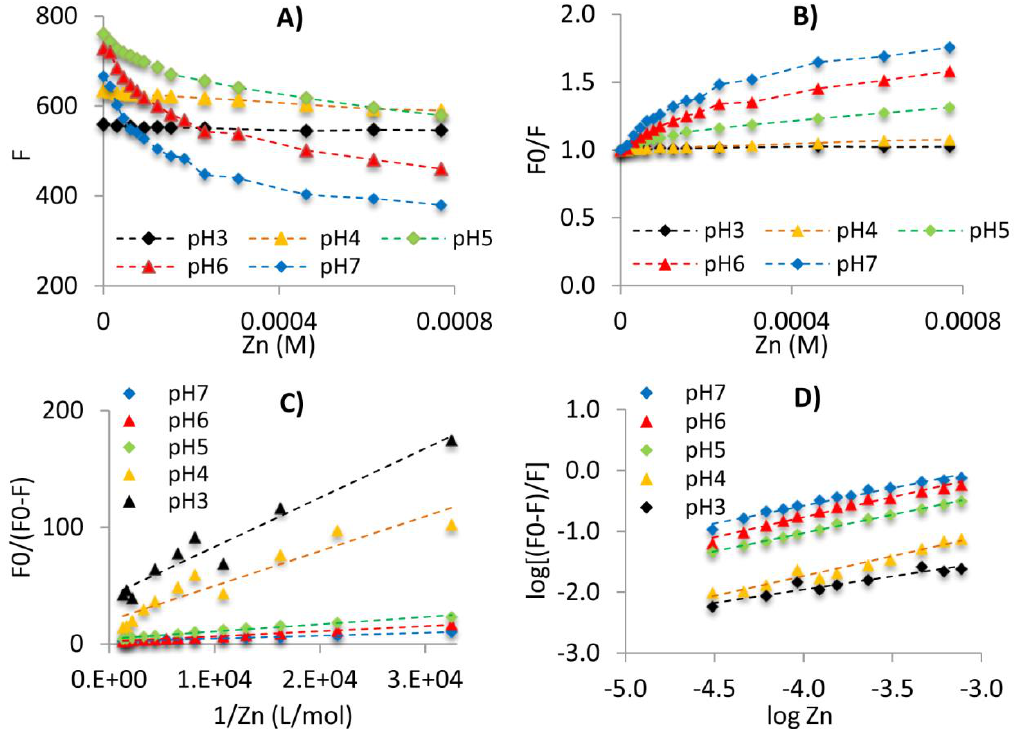
Figure 3. The analysis of fluorescence quenching data for A-peak of the FA5-Zn(II) system at pH 3–7. ( A ) fluorescence quenching profiles with Zn(II) increase; ( B ) Stern–Volmer plots; ( C ) modified Stern–Volmer plots; ( D ) double logarithmic plots.